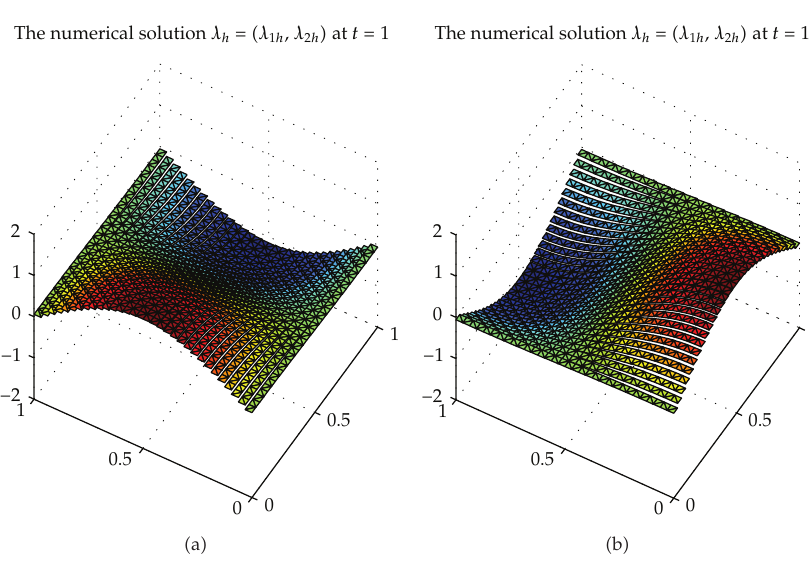
Figure 4: The numerical gradient λ 1 h (cid:3) a (cid:4) and λ 2 h (cid:3) b (cid:4)